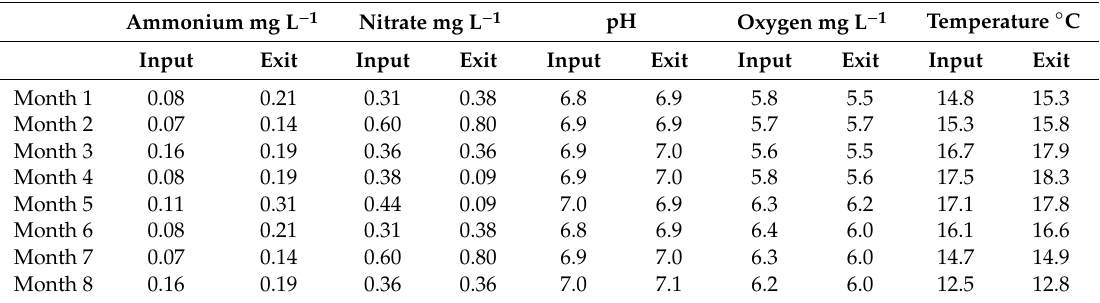
Table 3. Physical and chemical properties of water for aquaculture recirculation system for rainbow trout